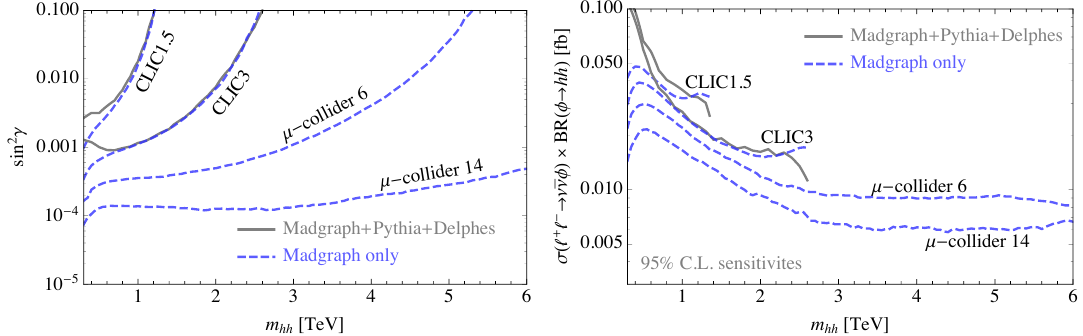
Figure 15. Comparison between the determination of sensitivities using Madgraph only (both at CLIC and future muon colliders) and the full results for CLIC, as a validation of our simpli(cid:12)ed analysis. Left: Higgs-singlet mixing angle, assuming BR( (cid:30) ! hh ) = 25%. Right: signal cross- section of a generic resonance produced in e + e (cid:0) and decaying to hh .